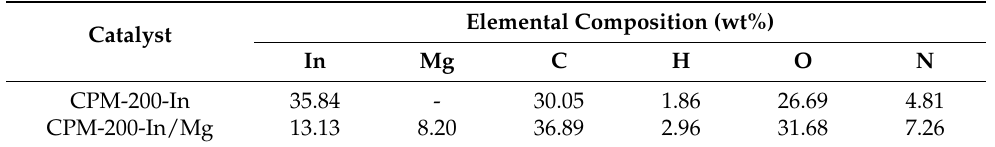
Figure 4. TGA curve of CPM-200-In and CPM-200-In/Mg. To verify the elemental composition of both catalysts, elemental analysis (EA) and inductively coupled plasma–optical emission spectrometry (ICP-OES) were conducted, and the results in wt% are given in Table 1. Table 1 . Elemental analysis (EA) and inductively coupled plasma (ICP) results of CPM-200-In and CPM-200-In/Mg. Elemental Composition (wt%) Catalyst